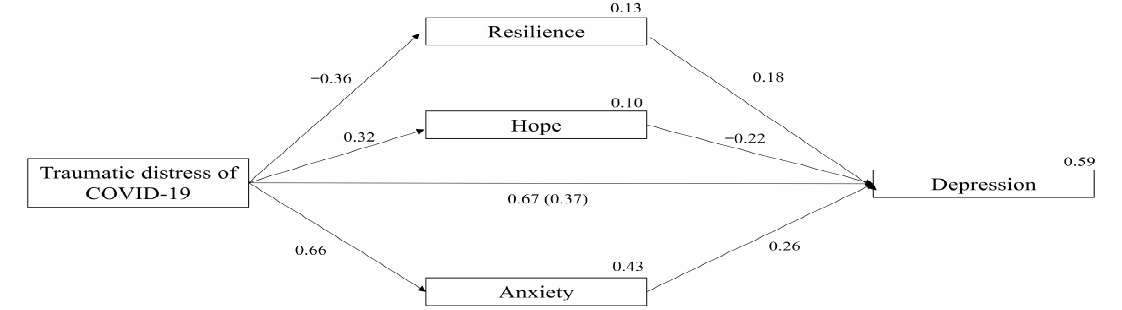
Figure 2. Mediation analyses predicting depression. Values on paths represent standardized β coefficients. Values on endogenous variables represent variance. Value in parenthesis represents the direct effect after considering all mediators in the model. All values are